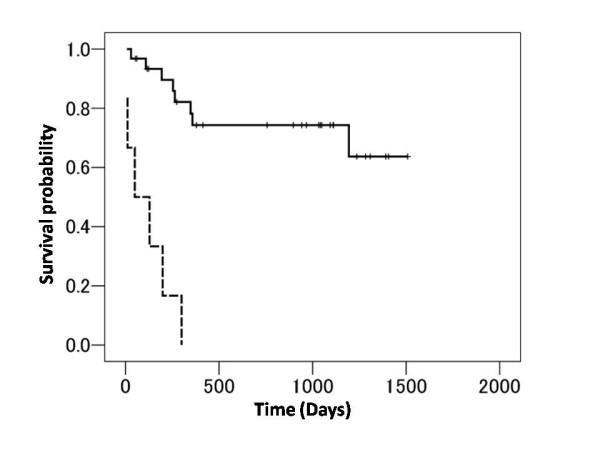
Kaplan-Meier estimates of survival in patients with or without hyperbilirubinemia. The broken and continuous lines indicate the patients with and without hyperbilirubinemia, respectively. Hyperbilirubinemia was defined as serum total bilirubin > 1.2 mg/dL.